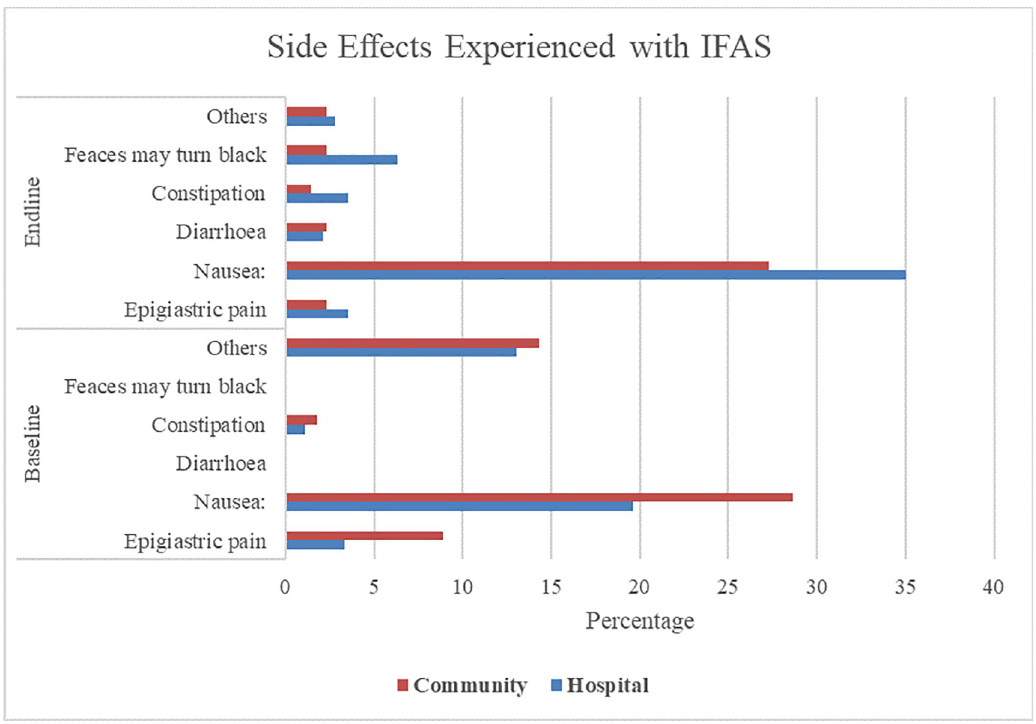
Fig 3. Side effects experienced by pregnant women with IFAS. This refers to the side effects experienced by pregnant women taking IFAS at both baseline and endline for both the control (hospital) and intervention (community)